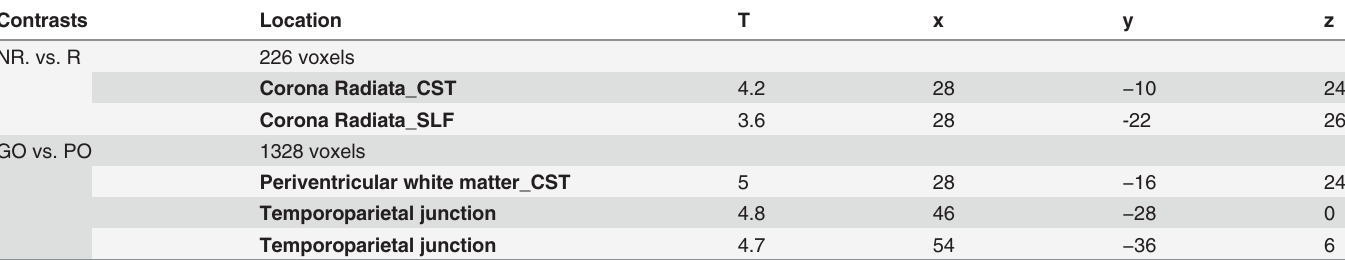
T is the value of the T-statistic. NR denotes the non recanalized patients and R the recanalized patients; GO: Good outcome de fi ned as a modi fi ed Rankin Scale from 0 to 2; PO: Poor outcome de fi ned as a modi fi ed Rankin Scale from 3 to 6; CST denotes corticospinal tract and SLF superior longitudinal